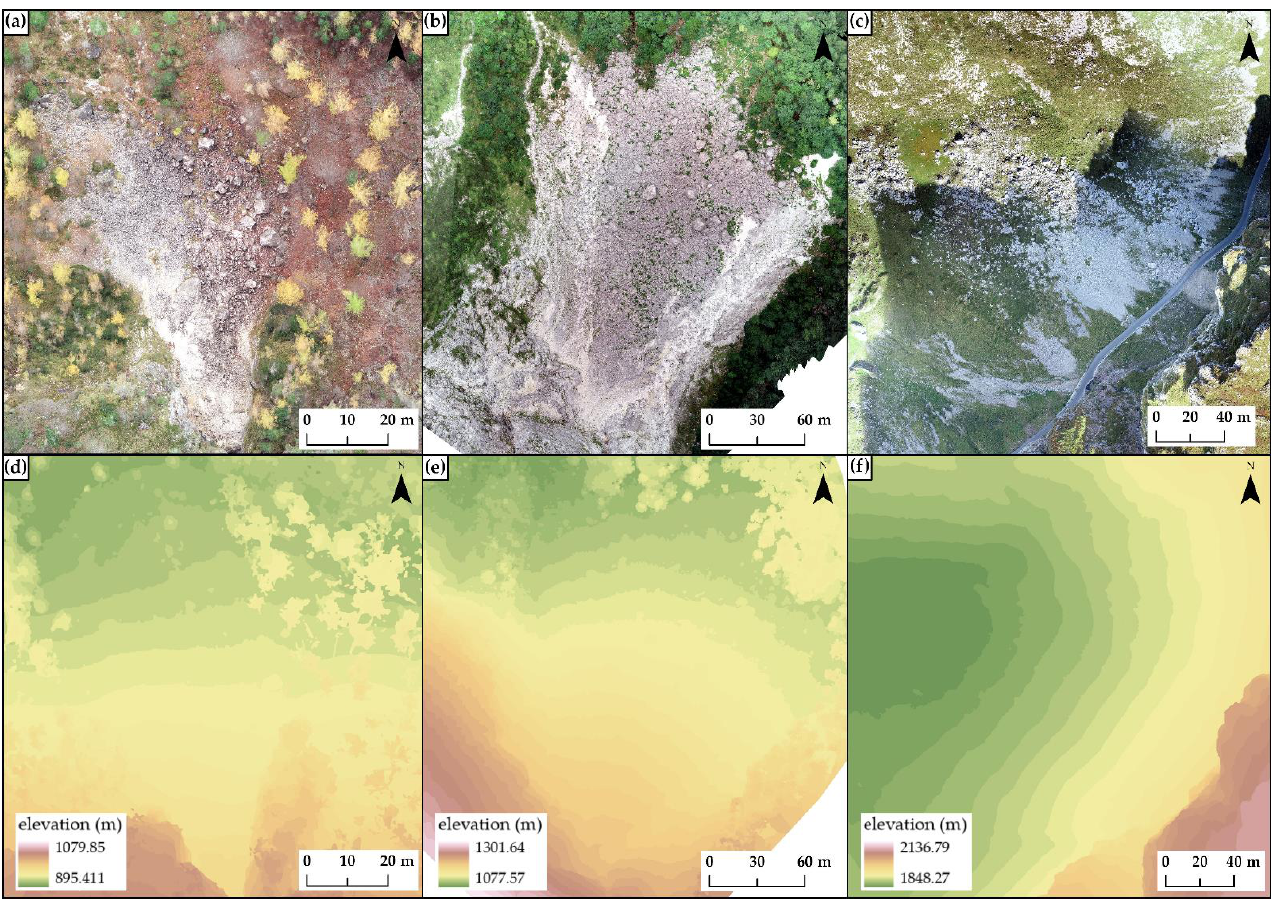
Figure 5. Final orthomosaics ( a – c ) and digital surface models (DSM) ( d – f ) for Kekec ( a , d ), Krnica ( b , e ), and Mangart ( c , f ). The presented products were all produced by using the BBA_traditional method.